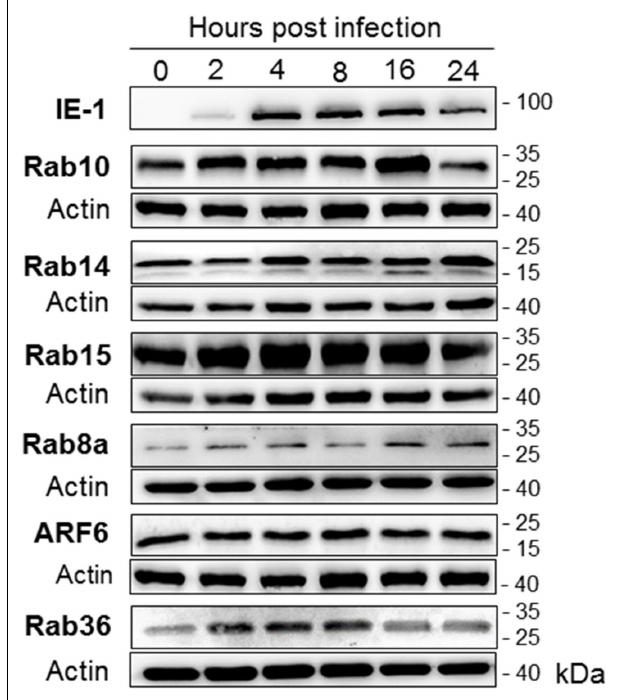
FIGURE 10 | The expression level of host-cell small GTPases that act at the EE-ERC-TGN interface. Western-blot analysis was performed using lysates of uninfected (0 hpi) and MCMV-infected ( (cid:49) m138-MCMV, MOI 10) Balb 3T3 cells at various stages of infection (2–24 hpi). The kinetic expression of each small GTPase was determined by simultaneous analysis of MCMV IE1 protein (shown is a representative image) and β -actin at the same membrane. Shown are images of representative experiments out of 3–5 experiments. 1-column fitting